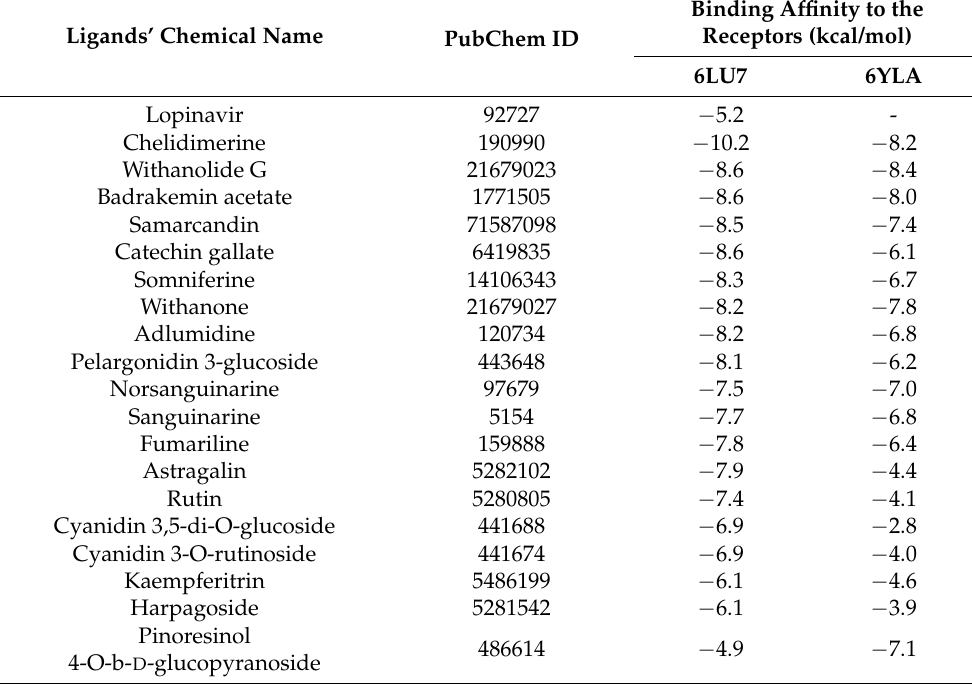
Table 1. Binding analysis of the ligands against SARS-CoV-2 receptors using AutoDock